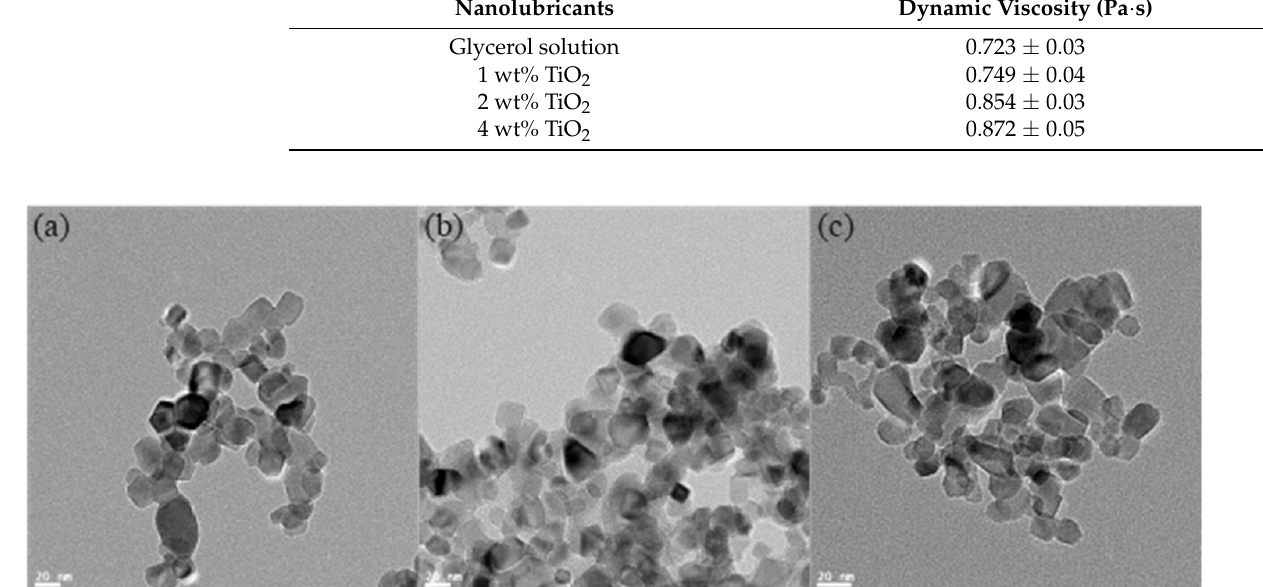
Figure 5. TEM images of TiO 2 NPs dried from different weight concentrations lubricants: ( a ) 1 wt%; ( b ) 2 wt%; and ( c ) 4 wt%.